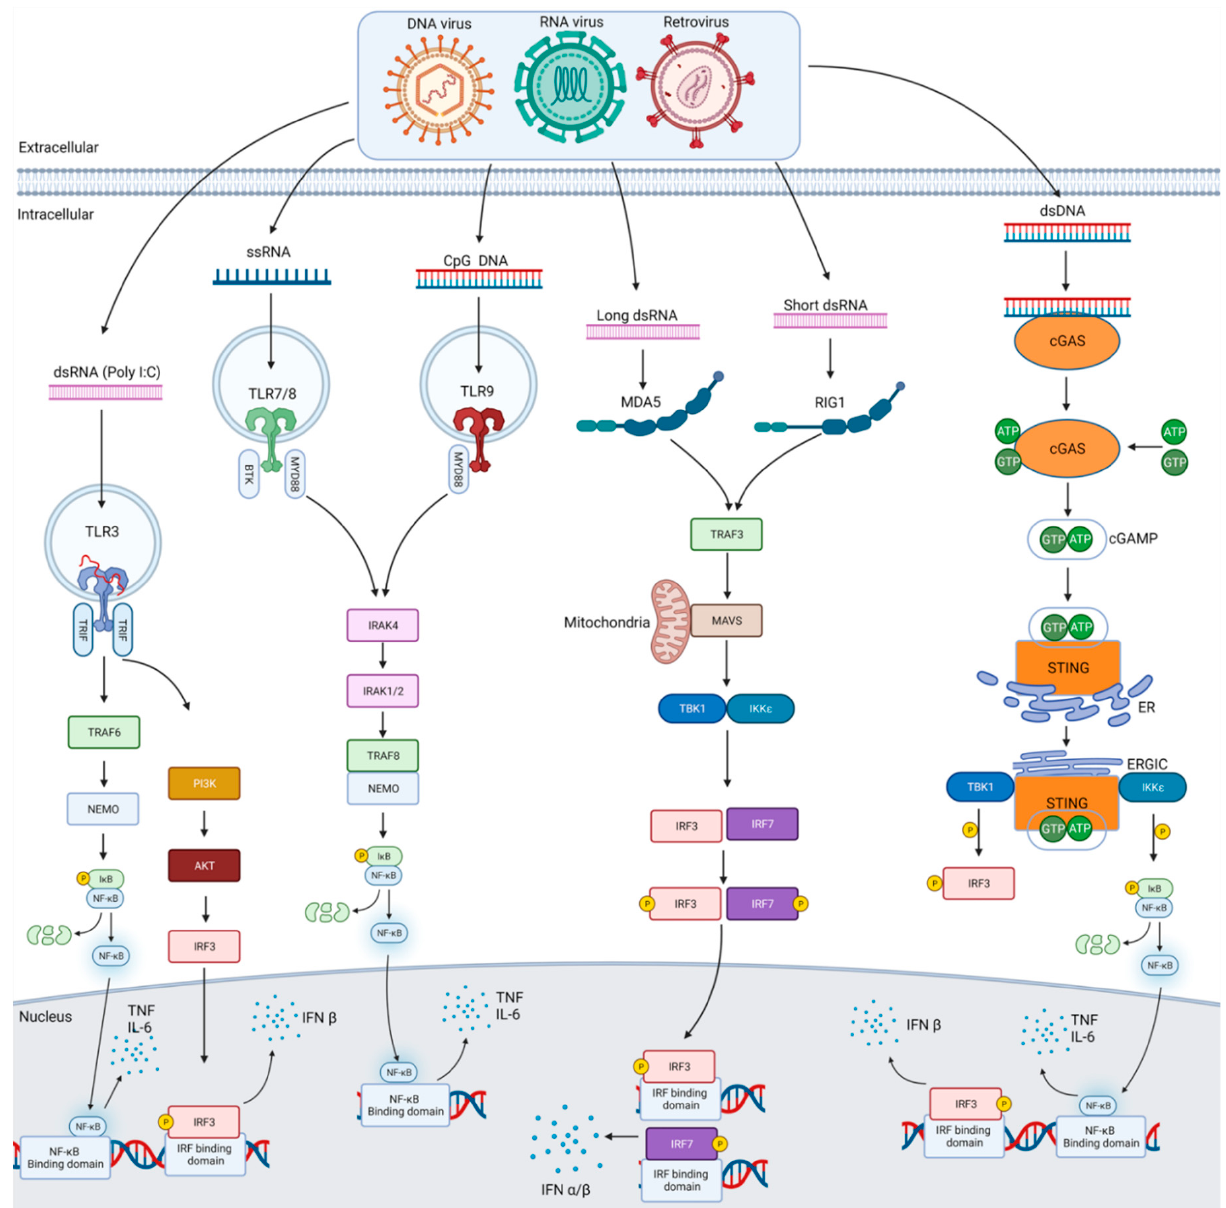
Figure 1. Anti-viral pattern recognition signalling pathways. Shown in this figure are the various signalling pathways used to respond to viral infection from DNA, RNA and retroviruses. Each of the major forms of nucleic acids that act as PAMPs from such viruses are illustrated along with the PRRs they bind to including TLRs, RLRs and DNA sensors such as cGAS. Each pathway activates specific kinases via their own adaptor molecules, and this ultimately leads to the activation of transcription factors that translocate to the nucleus and help initiate the transcription of cytokines such TNF α and IL6 or type I interferons, e.g., IFN β , which then get released from the cell.